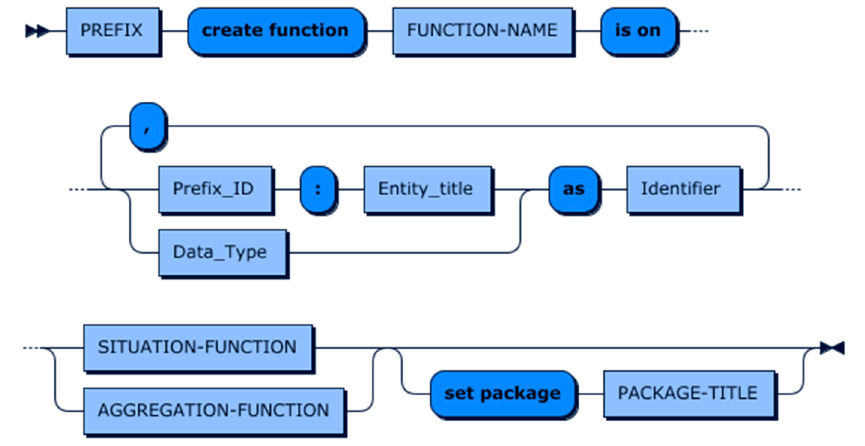
Figure 17. Create function production rule.